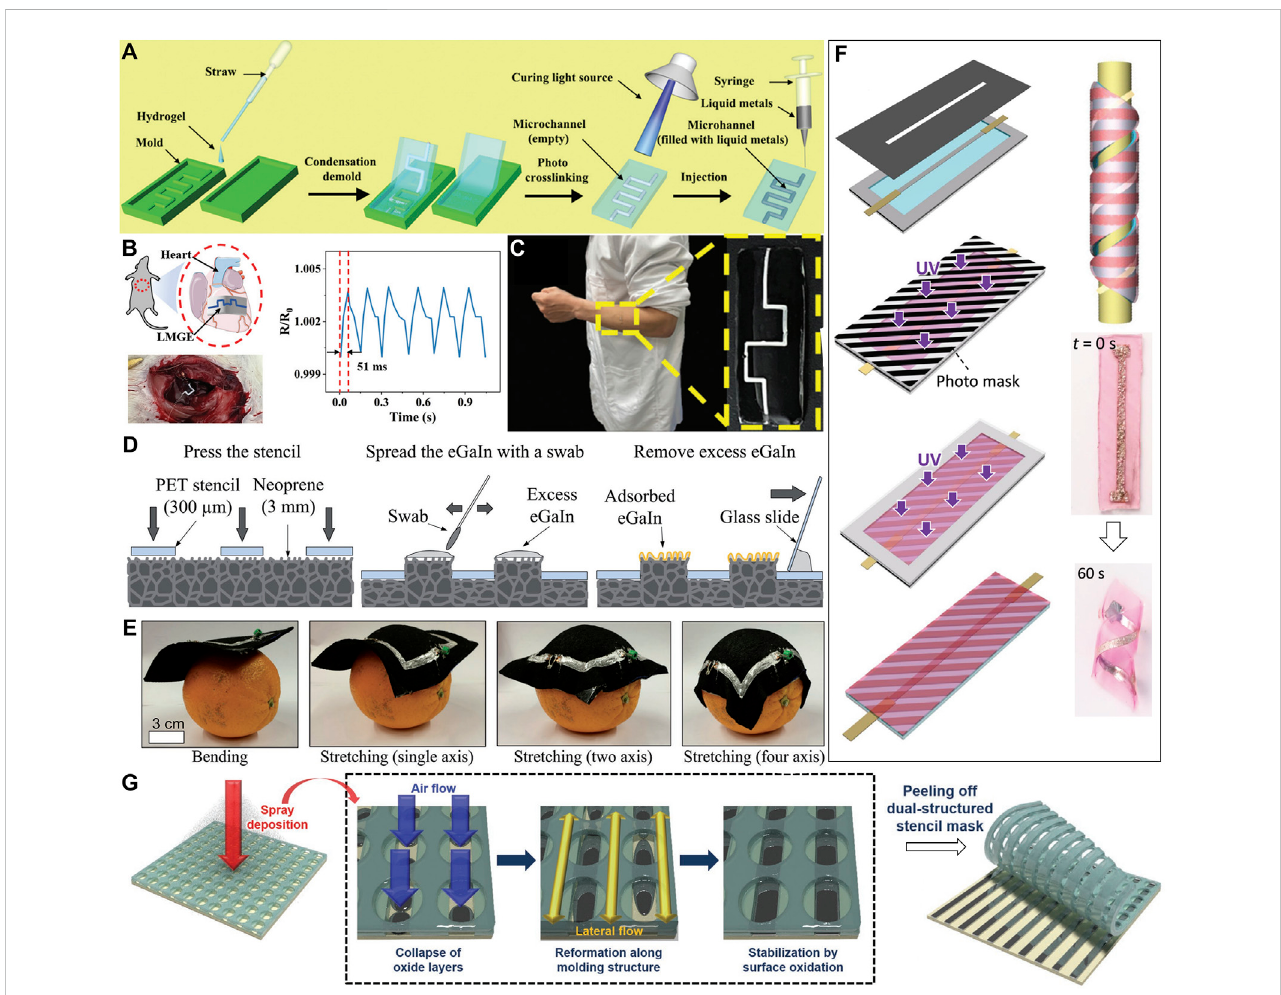
FIGURE 4 (A) The manufacturing process of LMGE (Yuan et al., 2022). Copyright@2022, RSC (B) Schematic diagram of LMGE monitoring heartbeat and resistance changesofLMGEasafunctionofmonitoringheartbeat(Yuanetal.,2022).Copyright@2022,RSC (C)